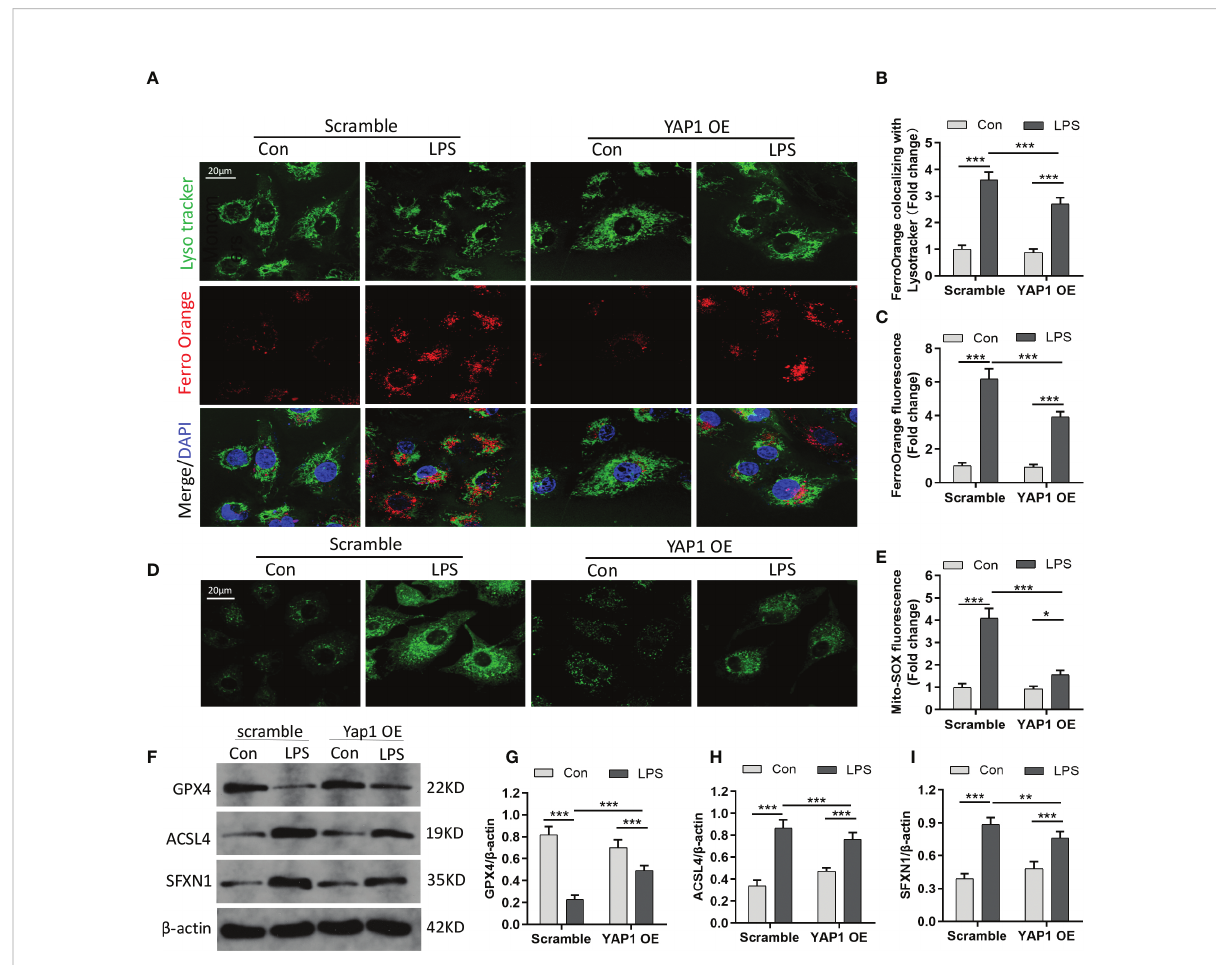
FIGURE 2 YAP1 activation inhibited ferroptosis by decreasing the amount of intracellular free ferrous iron. (A) LysoTracker (green) and FerroOrange (red) were shown by confocal imaging in MLE-12 cells stimulated with LPS. The images exhibited the localization of ferrous iron in survival cells. The lysosomes were stained by LysoTracker Green fl uorescence. Nuclei were stained with DAPI (blue). (B) Quanti fi cation of the fl uorescence intensity of FerroOrange colocalized with LysoTracker (green). (C) Quanti fi cation of the FerroOrange fl uorescence intensity. (D) Representative images of mitochondrial ROS stained with MitoSOX (green). (E) Quantitative results of mitochondrial ROS. (F – I) The expression levels of GPX4 (G) , ACSL4 (H) , and SFXN1 (I) were shown by WB. Data are expressed as mean ± SD. n = 3; * p < 0.05, ** p < 0.01, *** p <